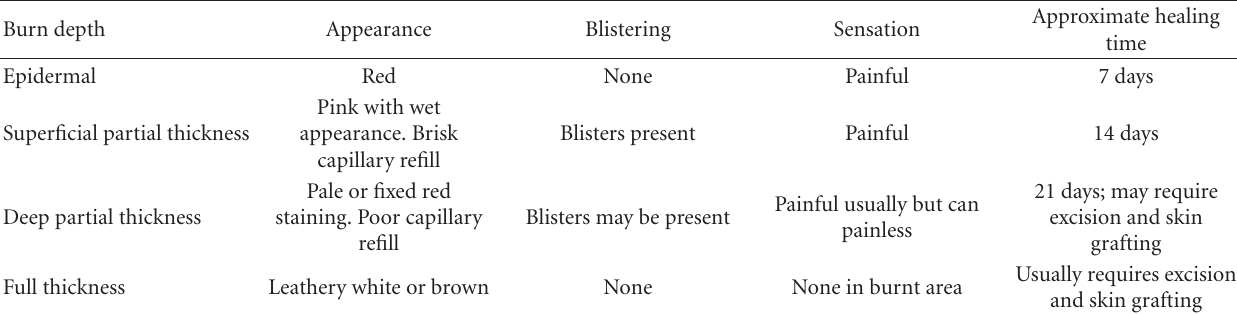
Table 2: Some salient features of varying burn depths and their approximate healing